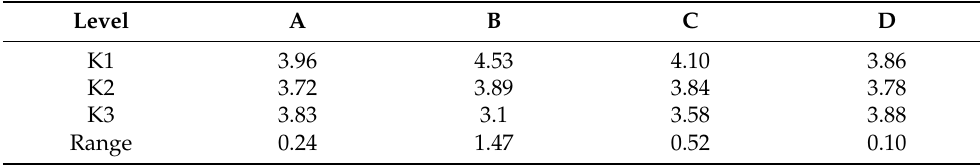
Table 9. Range analysis table of influencing factors of FLS.